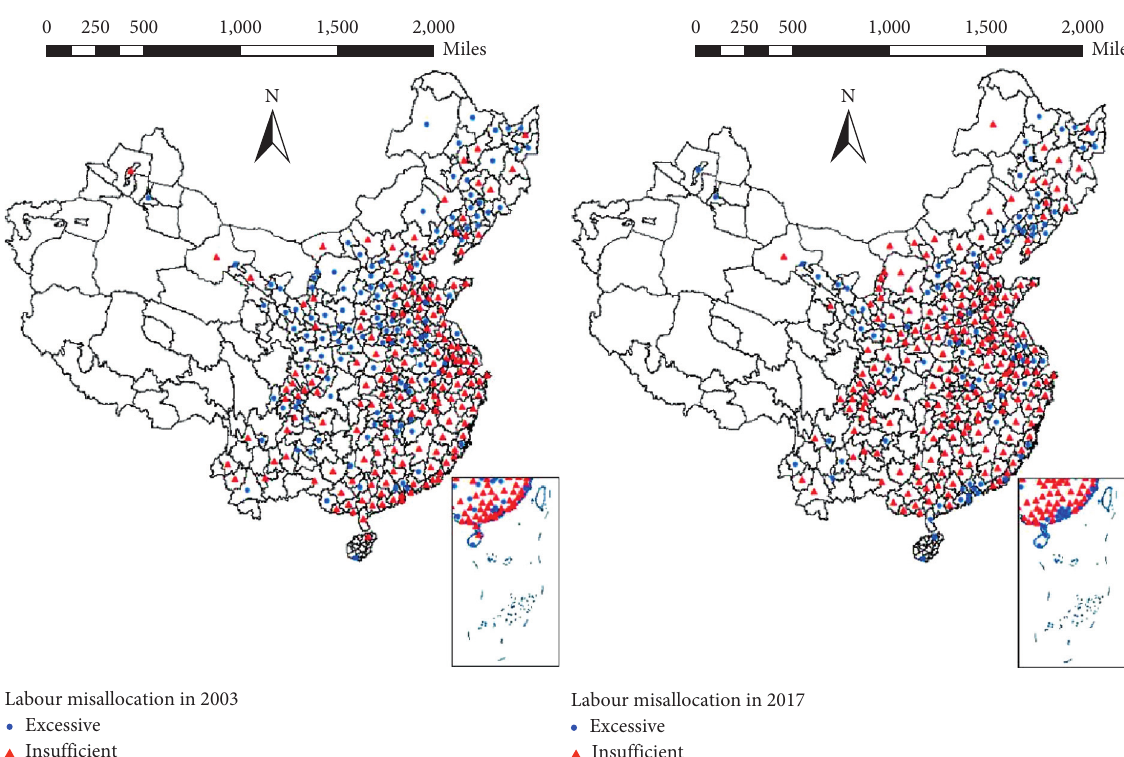
Figure 3: The spatial distribution pattern of labour misallocation in 2003 and